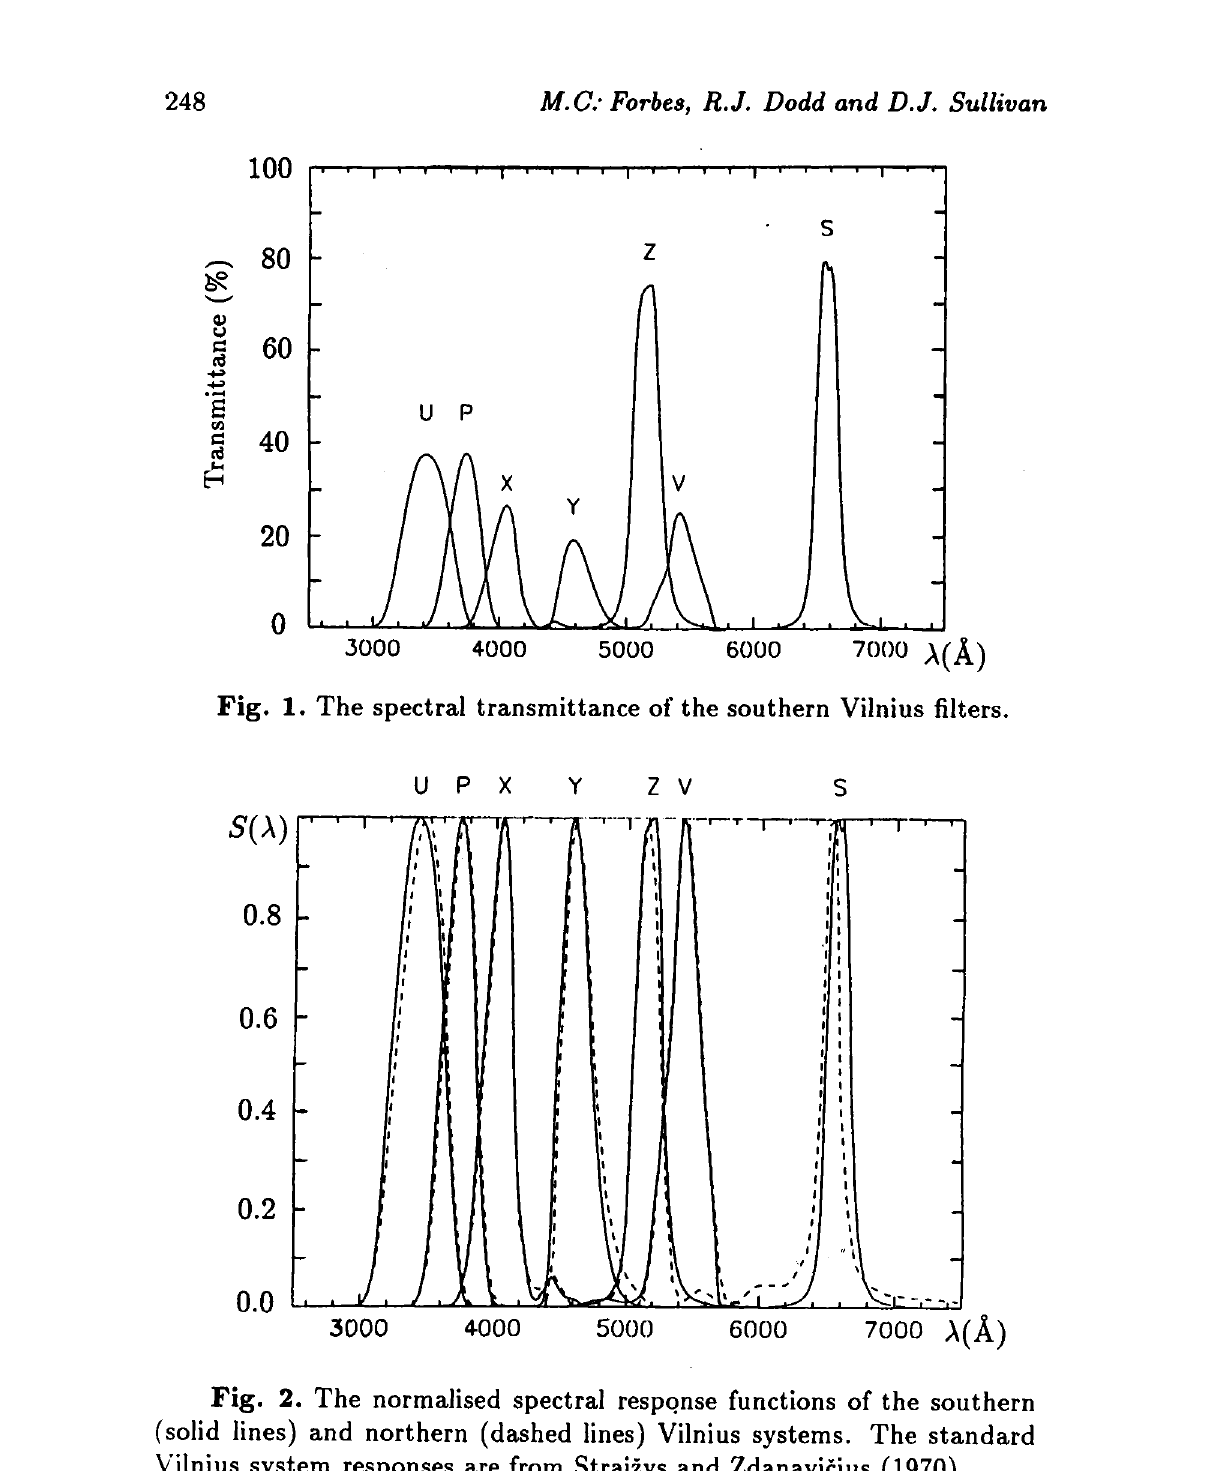
Fig. 2. The normalised spectral response functions of the southern (solid lines) and northern (dashed lines) Vilnius systems. The standard Vilnius system responses are from Straizys and Zdanavicius